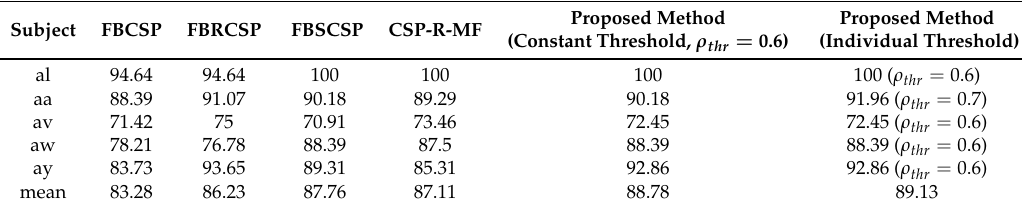
Table 3. Classification accuracy of the FBCSP variations and proposed method for 18 channels ( K = 18) BCI Competition III Dataset IVa.